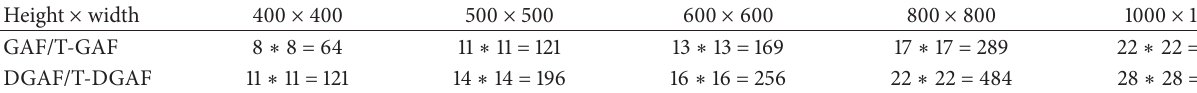
Table 1: Number of square grids for different size of target regions.